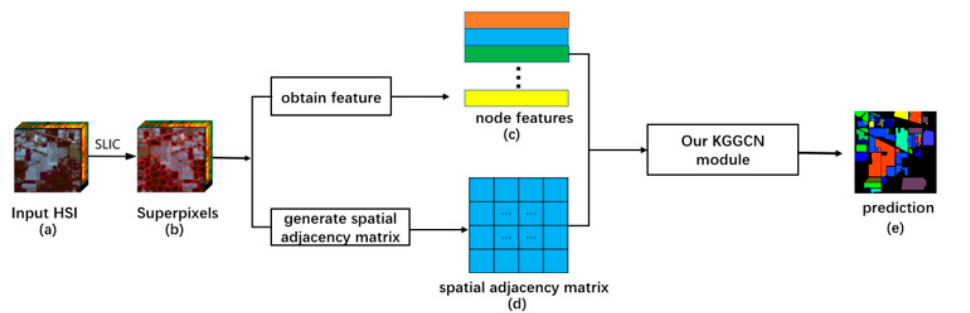
Figure 26. Data flow in our model. ( a ) is the original hyperspectral image. ( b ) shows the superpixels segmented by SLIC algorithm. ( c ) are node features. ( d ) is a spatial adjacency matrix. ( e ) is the prediction result of our model.